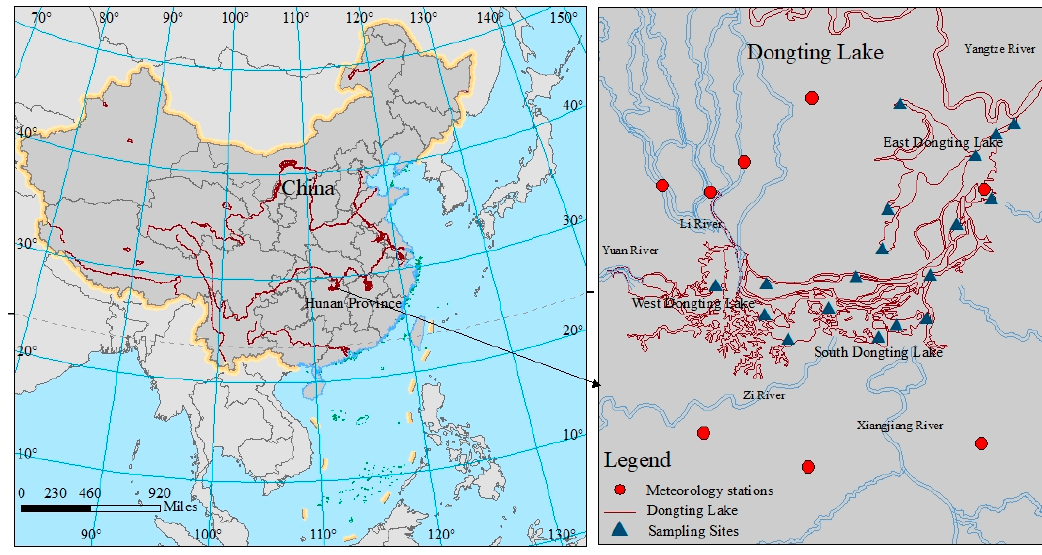
Figure 1. Location of the study area.